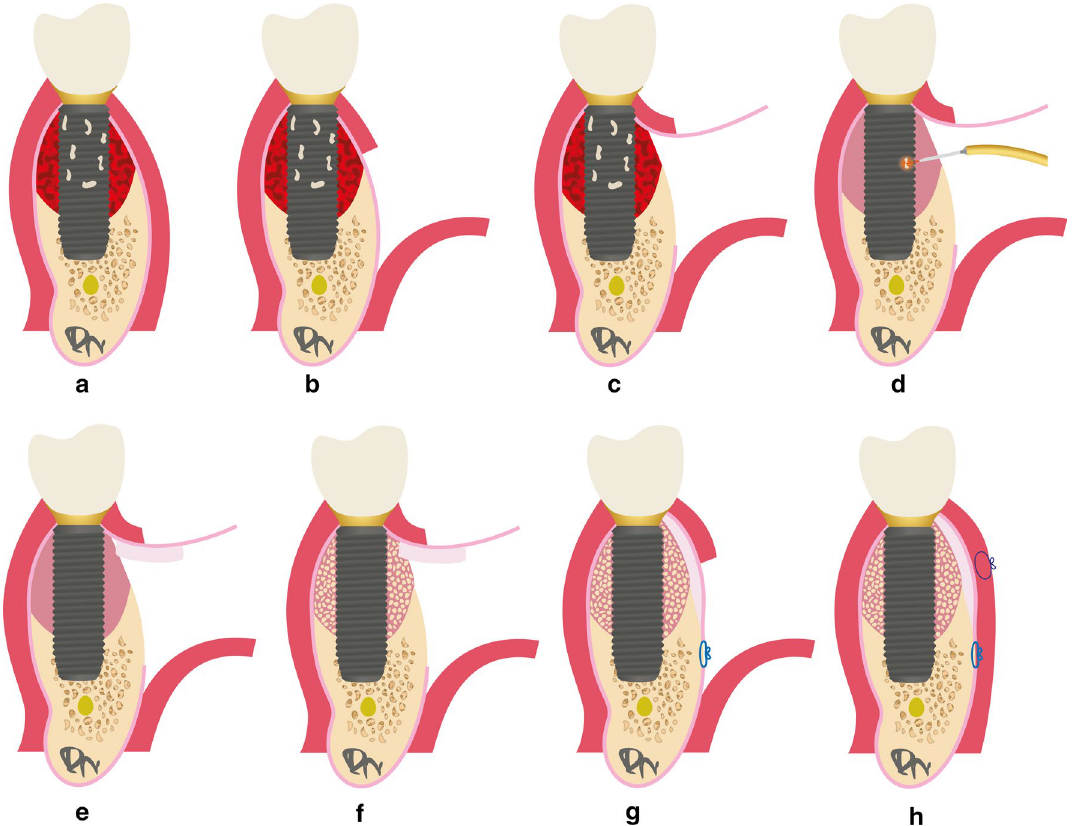
Fig. 1 Illustration of the LAPIDER treatment approach. a Presence of a severe peri‑implantitis defect. b Split‑flap preparation from mucogingival border in apical direction. c Apical separation of the periosteum and subperiosteal coronal flap elevation. d Peri‑implant defect cleaning and decontamination of the implant surface by the Er:YAG laser. e Subperiosteal connective tissue grafting. f Peri‑implant defect augmentation with autogenous bone chips. g Periosteal mattress suturing with resorbable suturing material. h Mucosal suturing for a bilaminar wound